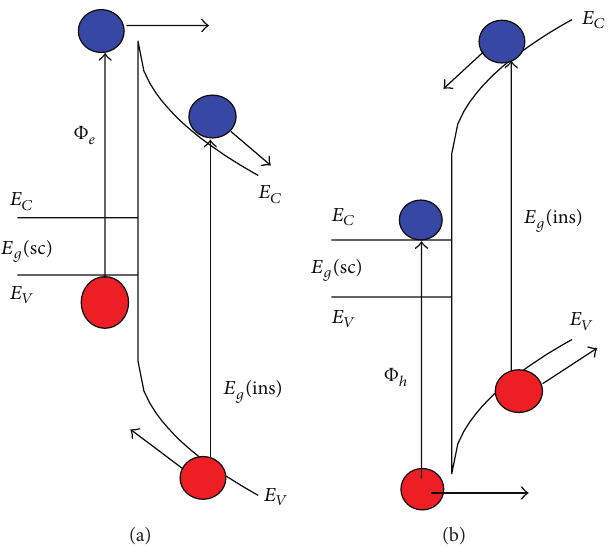
Figure 2: Schematic semiconductor/insulator energy band diagram for positive (a) and negative (b) bias applied to the top metal electrode (notshown),indicatingtheelectrontransitionsinthecaseofelectronIPE(threshold Φ 𝑒 )andholeIPE(threshold Φ ℎ )fromthesemiconductor intotheinsulatorandtheinsulatorPC(threshold 𝐸 𝑔 (ins)).Thankstotheexternallyappliedelectricfield,thethresholds Φ 𝑒 and Φ ℎ correspond to the energy position of the insulator band edges at the interface, not influenced by the charges distributed over the remaining thickness of the insulating layer. 𝐸 𝑔 (sc) refers to the width of semiconductor